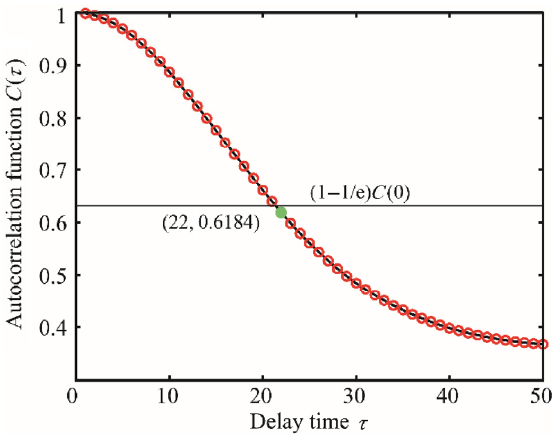
Fig. 6 Autocorrelation function for the time delay from test 4 ( P = 0.258 Pa ， v = 0.911